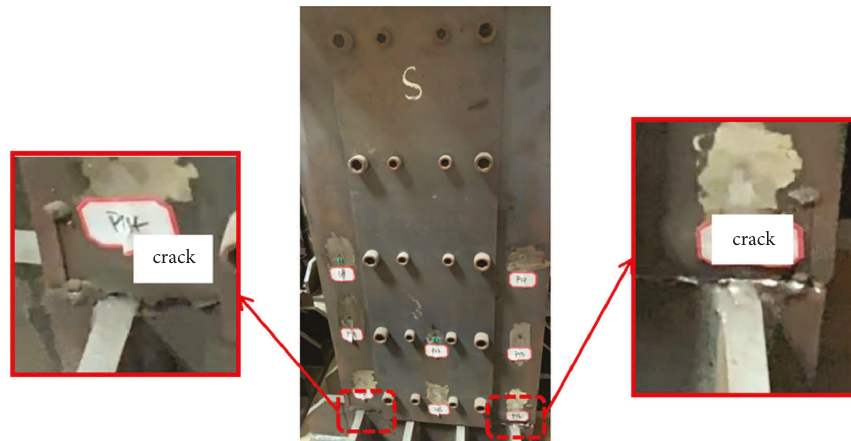
Figure 8: Failure mode of specimen II-1.